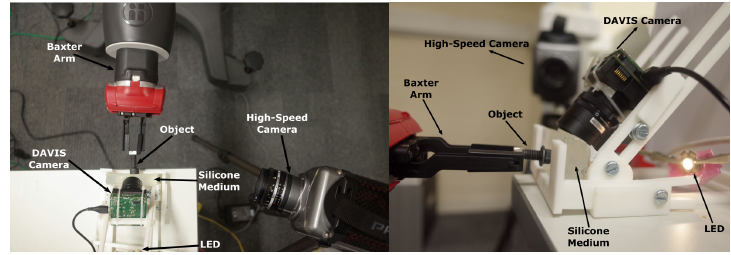
Figure 8. Top-down ( left ) and sideways ( right ) views of the experiment setup.